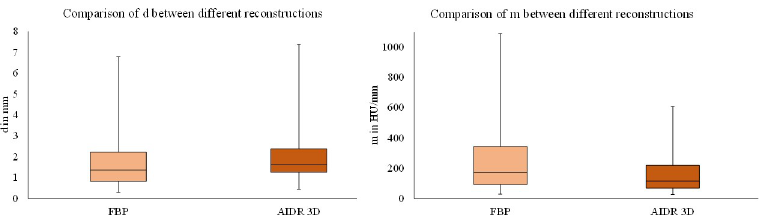
Fig 6. Boxplots of the comparison of contour sharpness parameters between FBP and iterative reconstruction. The comparison includes the distance between 25–75% of the maximal grey value (d; left diagram) and the slope in the contour (m; right diagram) between the two reconstructions—FBP and AIDR 3D strong levels. AIDR 3D was characterised by lower contour sharpness parameters, as indicated by higher values for the difference (d) and lower values for the slope